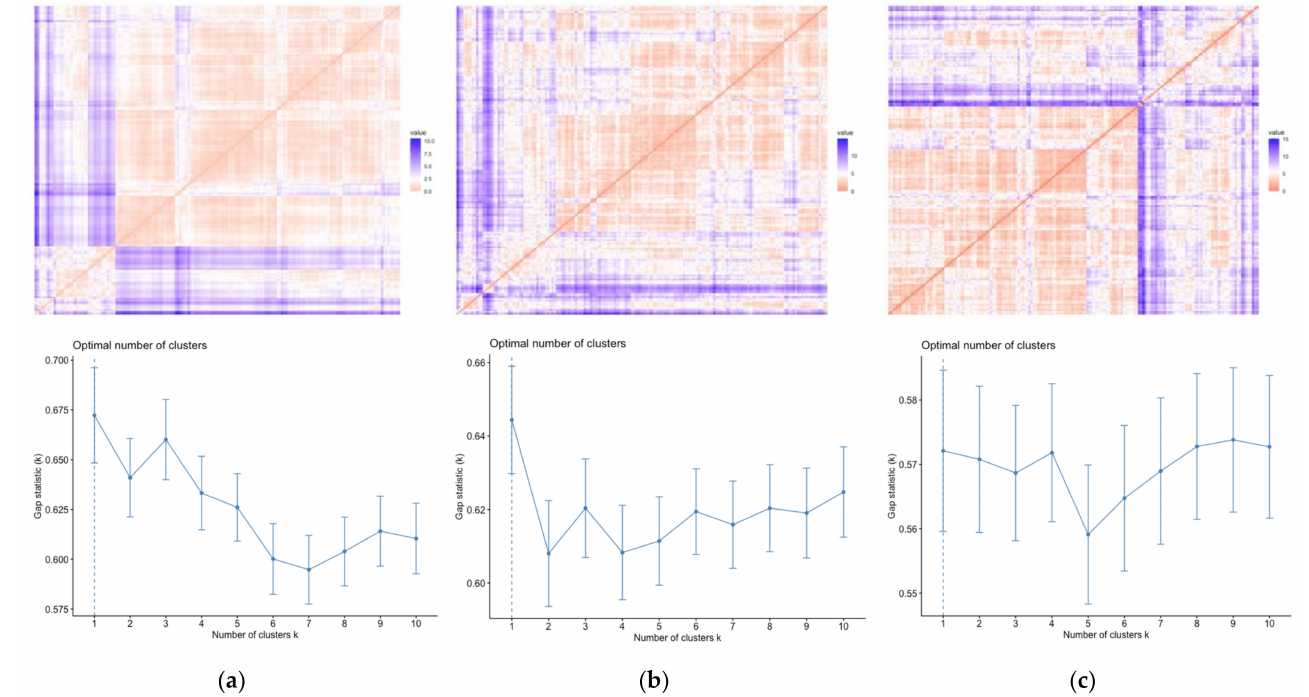
Figure 7. The top is the Hopkins statistic (Red: high similarity (i.e., low dissimilarity) | Blue: low similarity). Hopkins statistic: M = 0.83, GM = 0.77, M + GM = 0.75). The bottom is a cluster analysis of all bills of Chukar Partridges using all samples together without any locations information. ( a ) Morphometric ( M ; size), ( b ) geometric morphometric ( GM ; shape), and ( c ) M + GM